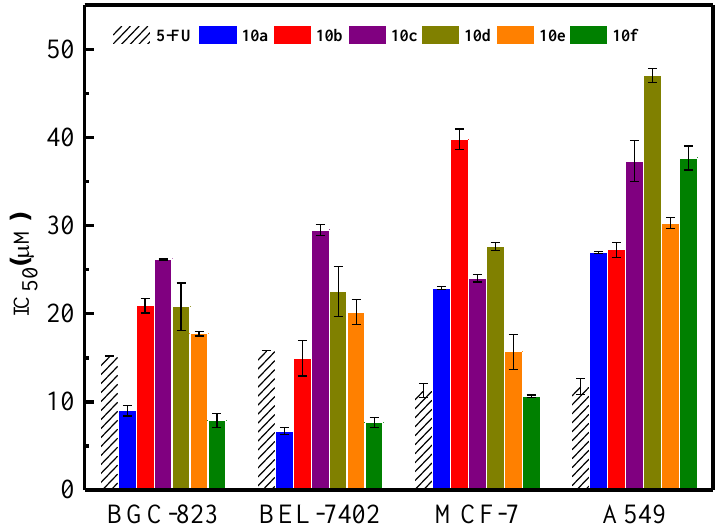
Figure 2. IC 50 values of 10a – 10f against BGC-823, BEL-7402, A549, and MCF-7 cells for 48 h.